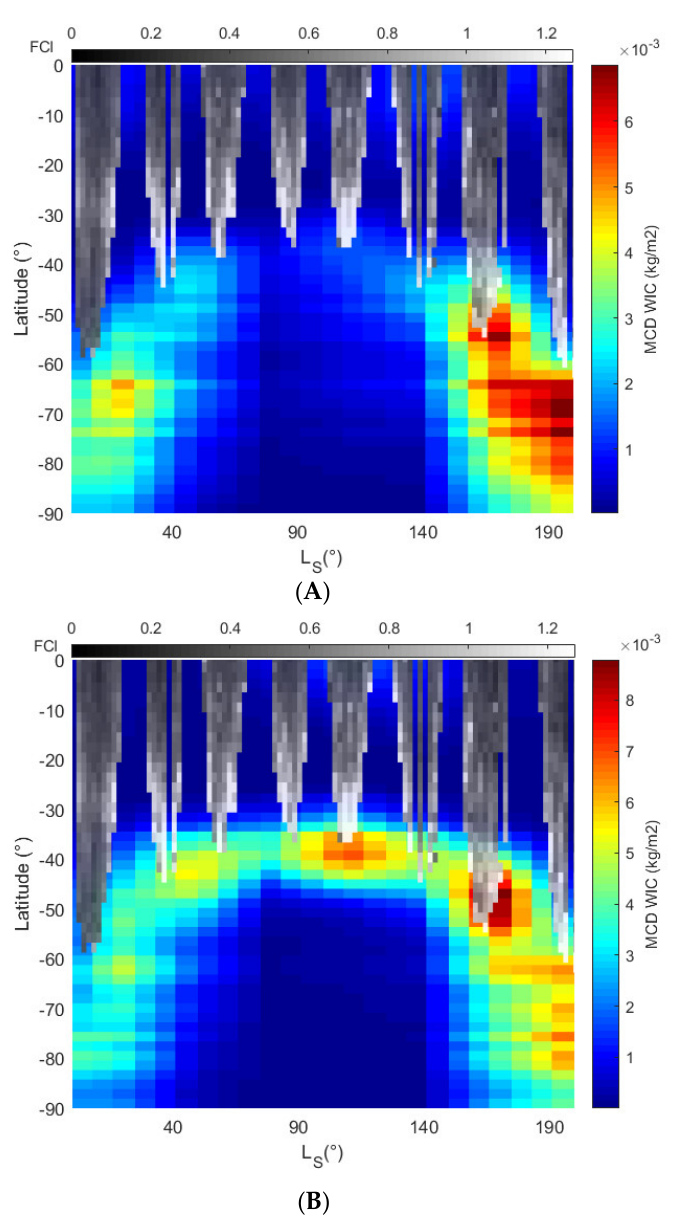
Figure 7. Comparison between the latitudinal-seasonal map of FCI (grey scale) with the one of MCD Water Ice Column (colour scale) for latitudes from 0° to 90°S and L S 0° to 200°. Grey scale: FCI results in region N (see Figure 6). Saturated FCI values are in white (>3.5σ, see Section 4.1). Colour scale: MCD Water ice column at 9 LTST ( A ), and 13 LTST ( B ).